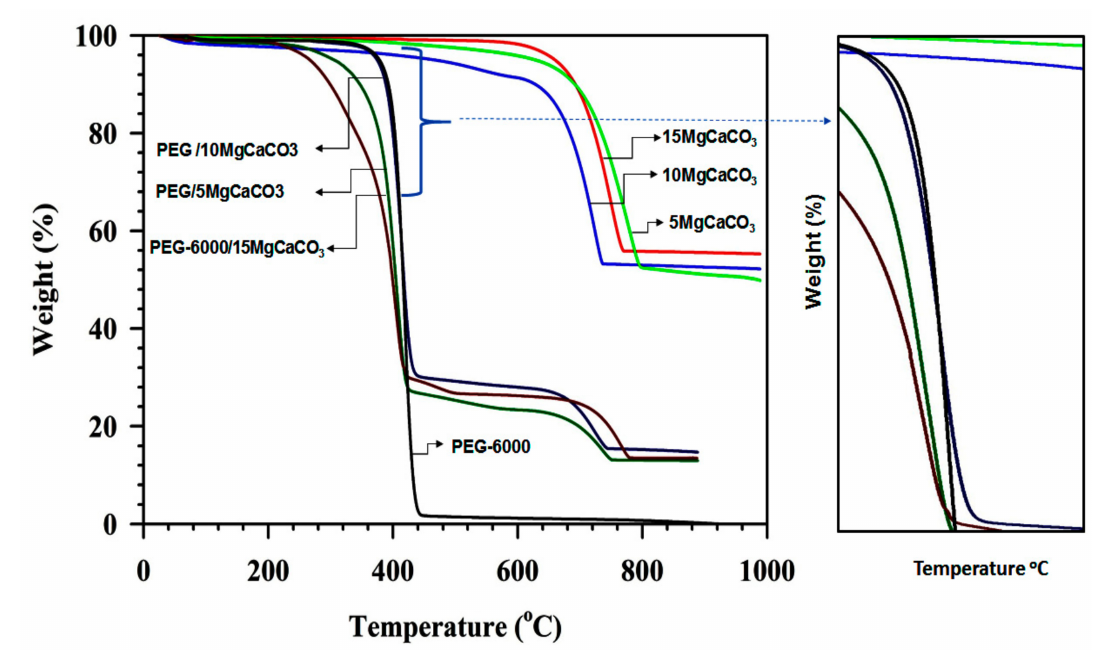
Figure 8. TGA curves of the pure ( a ) PEG, ( b ) 5-MCC, ( c ) 10-MCC, ( d ) 15-MCC, ( e ) P-5-MCC ( f ) P-10-MCC, and ( g ) P-15-MCC composites. The right-side figure is the enlarged part of the left side Figure (marked by arrow).